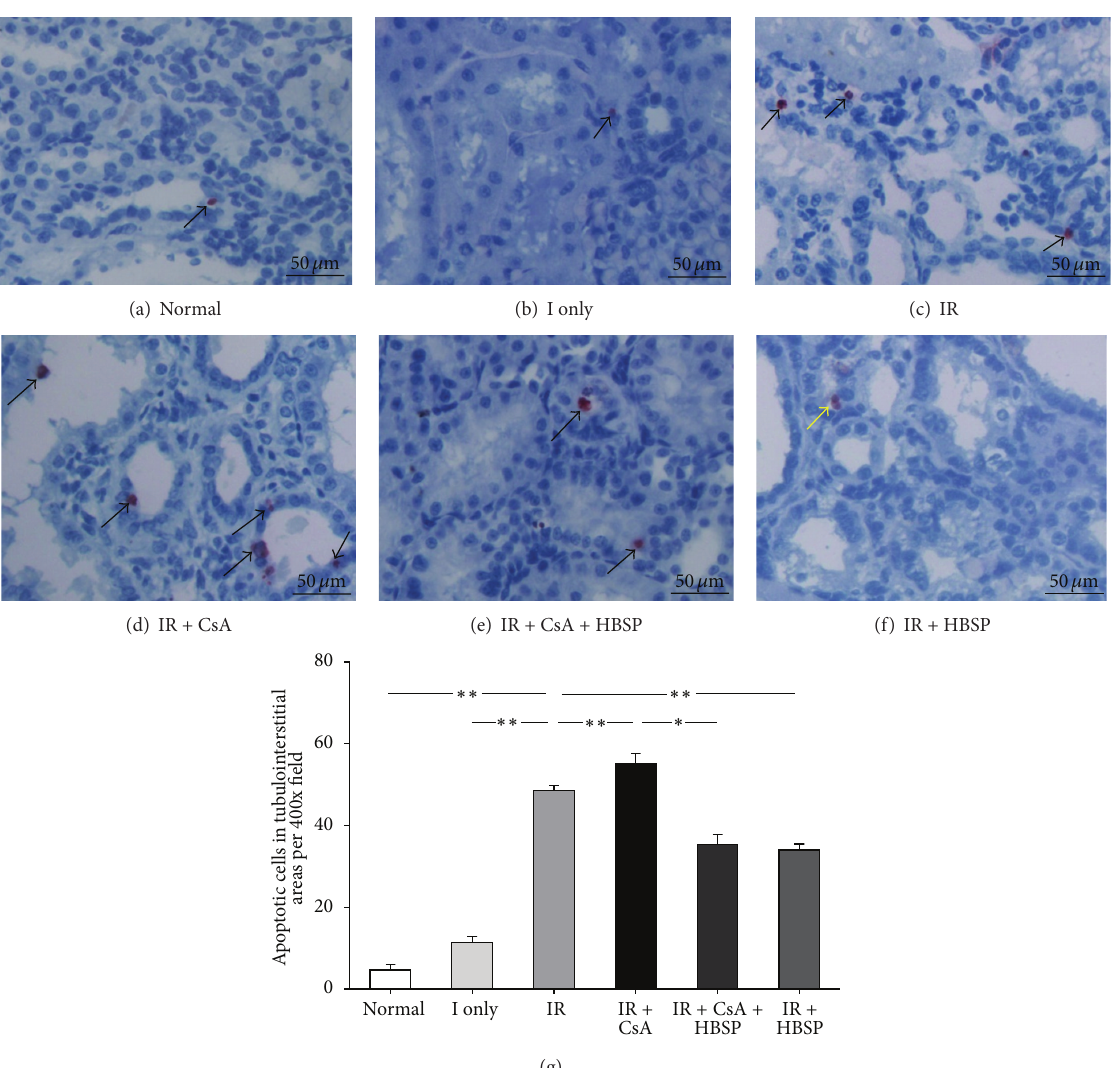
Figure 4: Apoptotic cells, labeled by fragmented DNAs, were mainly shown in tubular areas (a, d) and interstitial areas (b, c); some in tubular lumens (e); others with polymorphous nuclei ((f), yellow arrow). The number of apoptotic cells was significantly increased in the IR and IR + CsA kidneys but decreased by HBSP (g). Data are expressed as mean number per high power field of each group (mean ± SEM; 𝑛 = 6 ). ∗ 𝑃 < 0.05 ; ∗∗ 𝑃 < 0.01 .